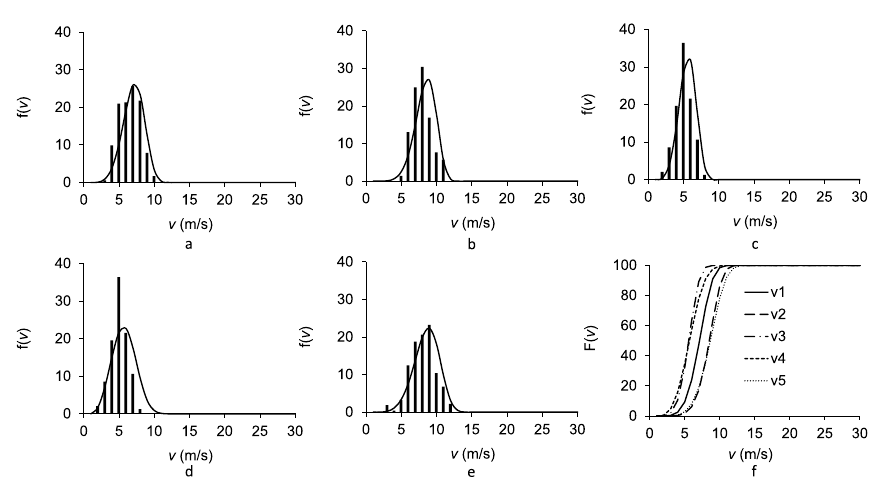
Table 4 Probability of occurrence Probability